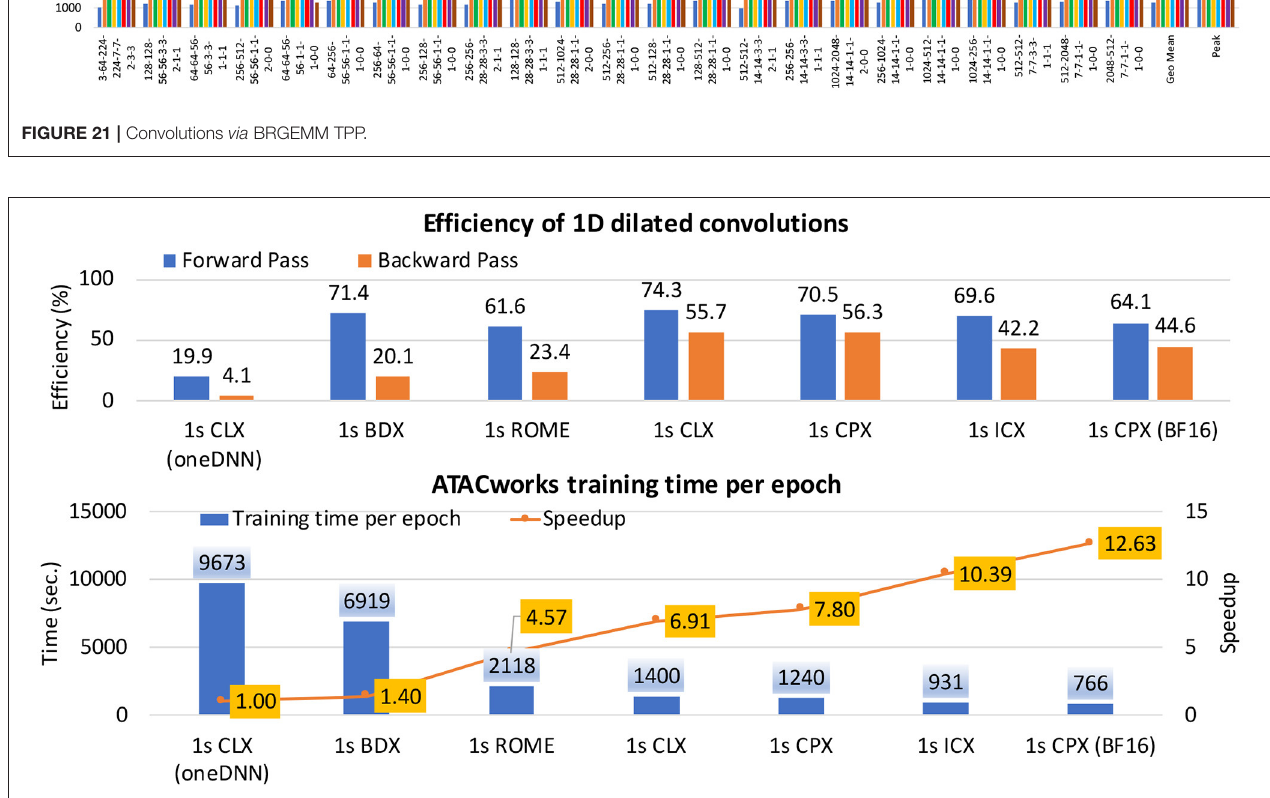
FIGURE 22 | 1D dilated